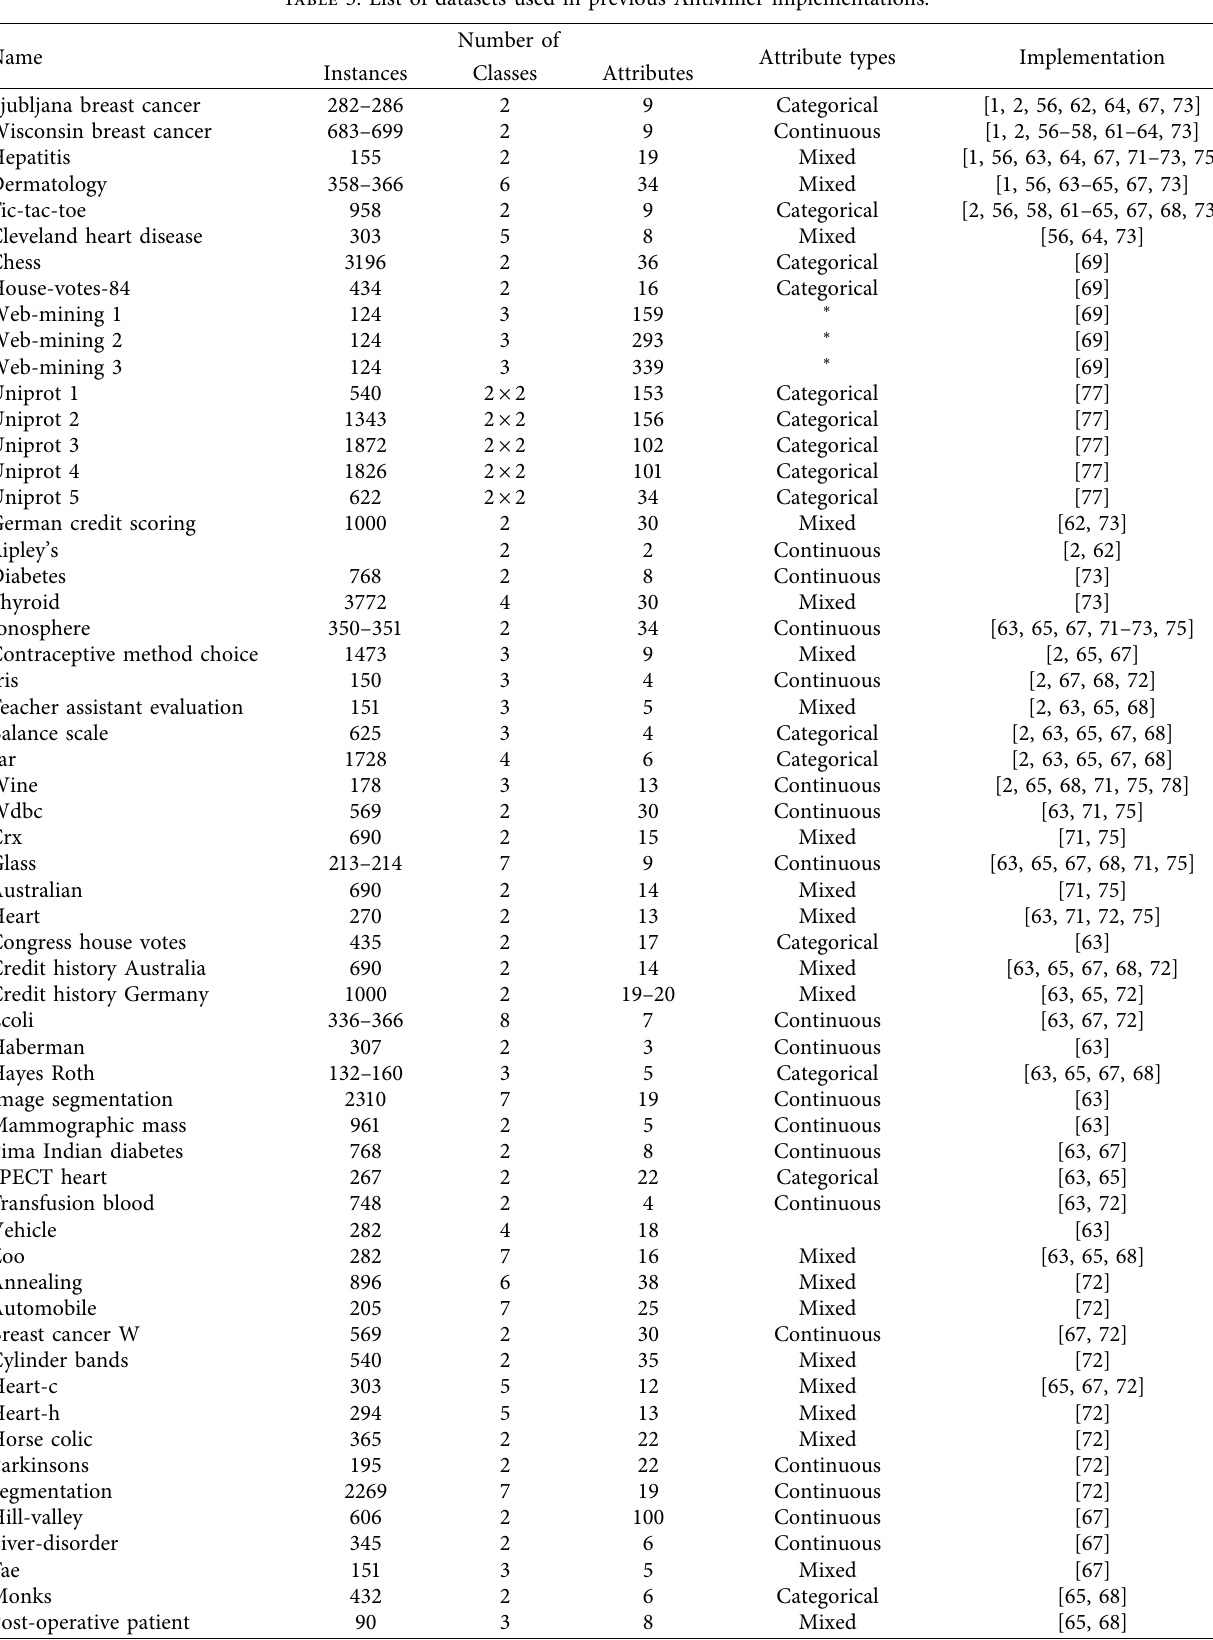
Table 5: List of datasets used in previous AntMiner